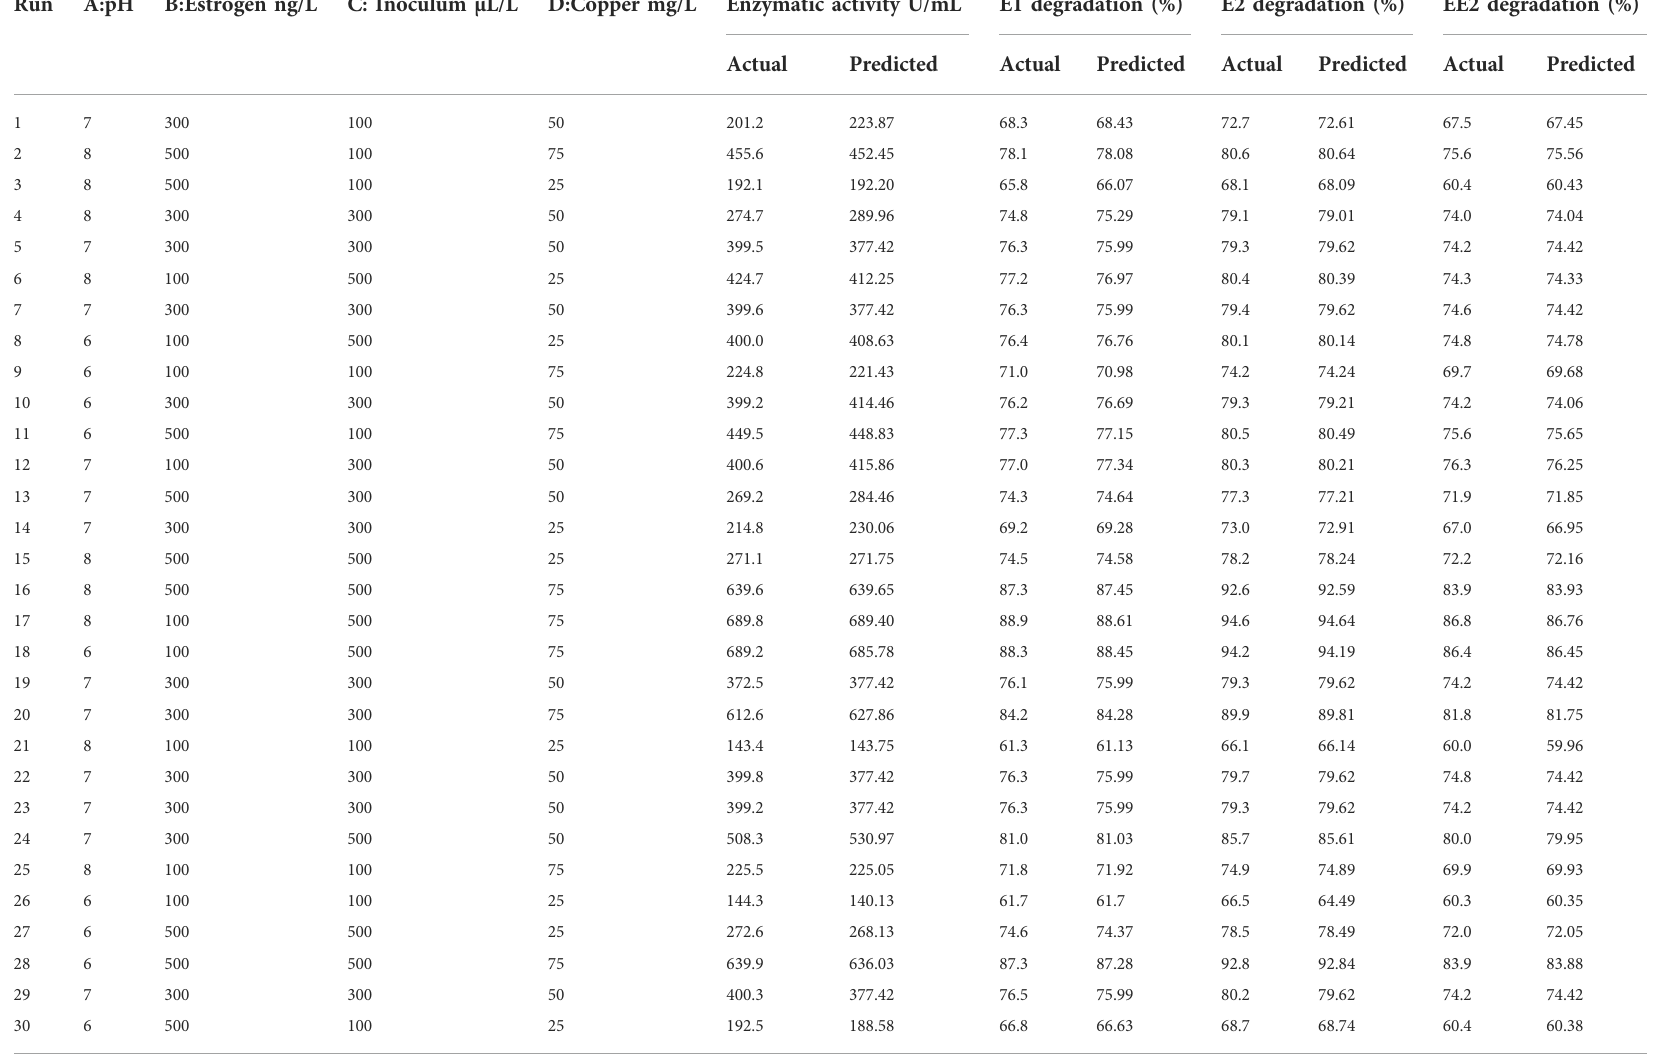
TABLE 2 CCD matrix showing actual and predicted responses for Lysinibacillus . BP2 estrogen degradation.